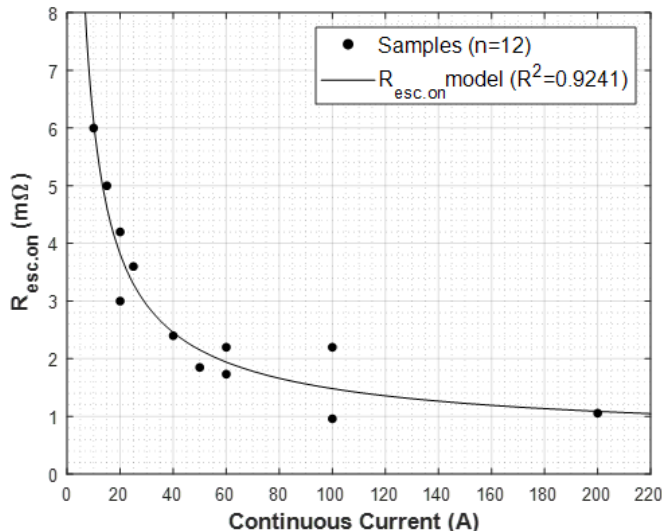
Figure 9. ESC continuous current vs. on-state resistance.